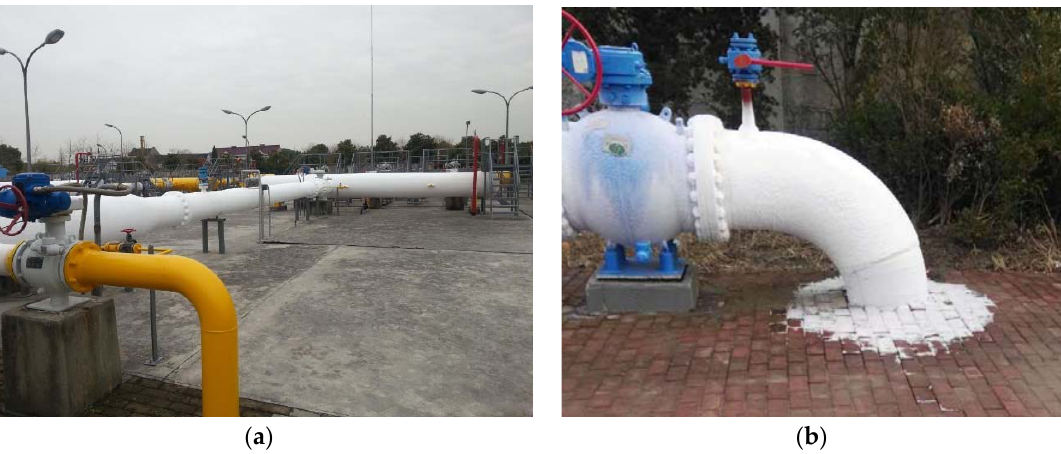
Figure 2. Frosting of pipes on the site: ( a ) frosting of the above-ground pipeline; ( b ) frosting of the pipeline into the ground.